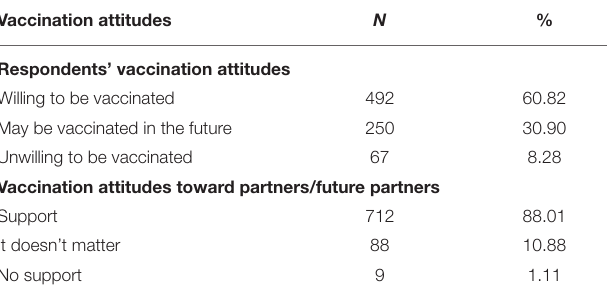
TABLE 3 | Respondents ’ attitudes toward HPV